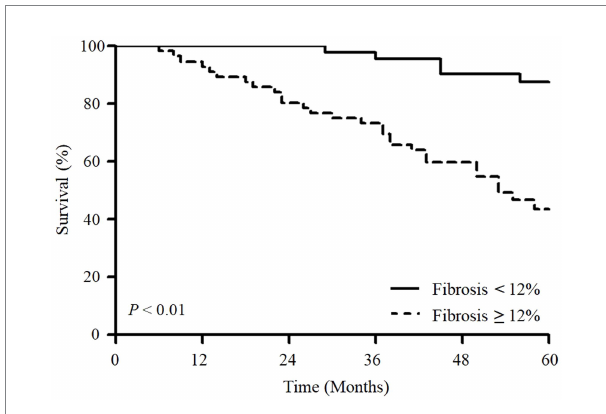
FIGURE 2 Kaplan–Meier survival analysis of overall survival according to fibrosis scores in patients with fibrotic HP. Patients with a fibrosis score above 12% had significantly worse survival than those with a score below 12% ( p <